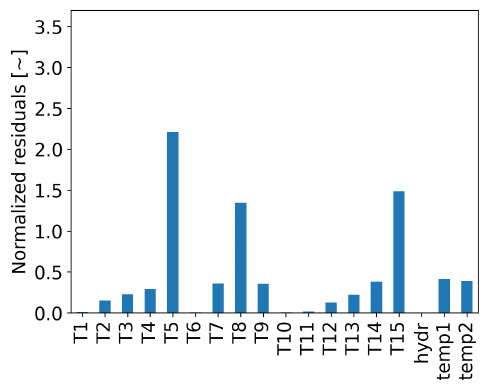
Figure 19. Autoencoder: bar plots of MAE residuals (June